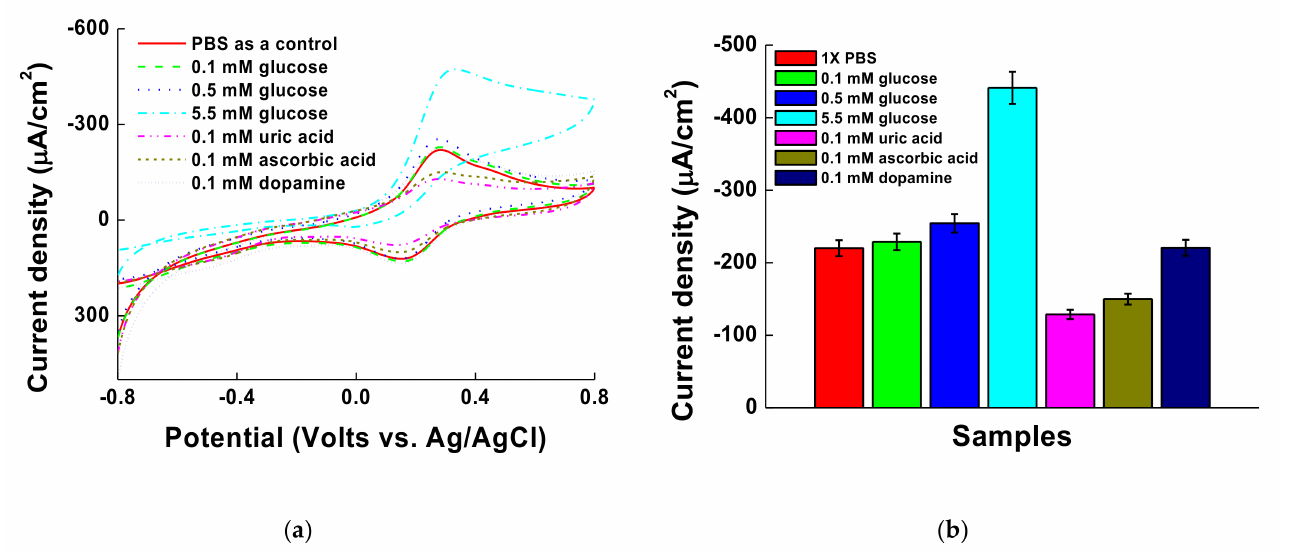
Figure 6. ( a ) Cyclic voltammogram and ( b ) bar graph of 0.1 mM UA, 0.1 mM AA, 0.1 mM DA, and glucose from 0.0 to 5.5 mM with Ru(dmo-bpy) 2 Cl 2 /GDH/PDA-MWCNT/SPCEs (in PBS; pH 7.0).